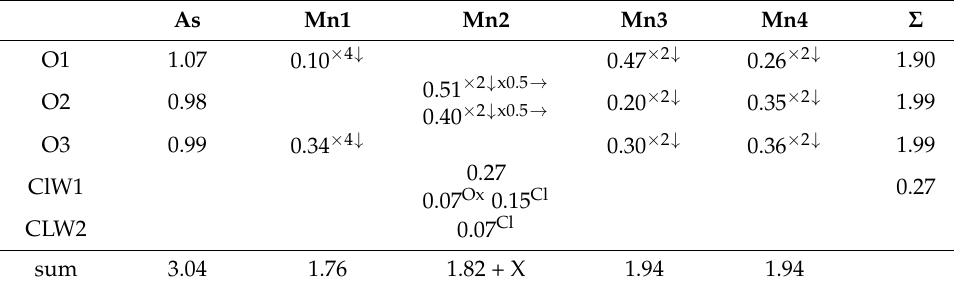
Table 5. Selected bond-valences * ( vu ) in